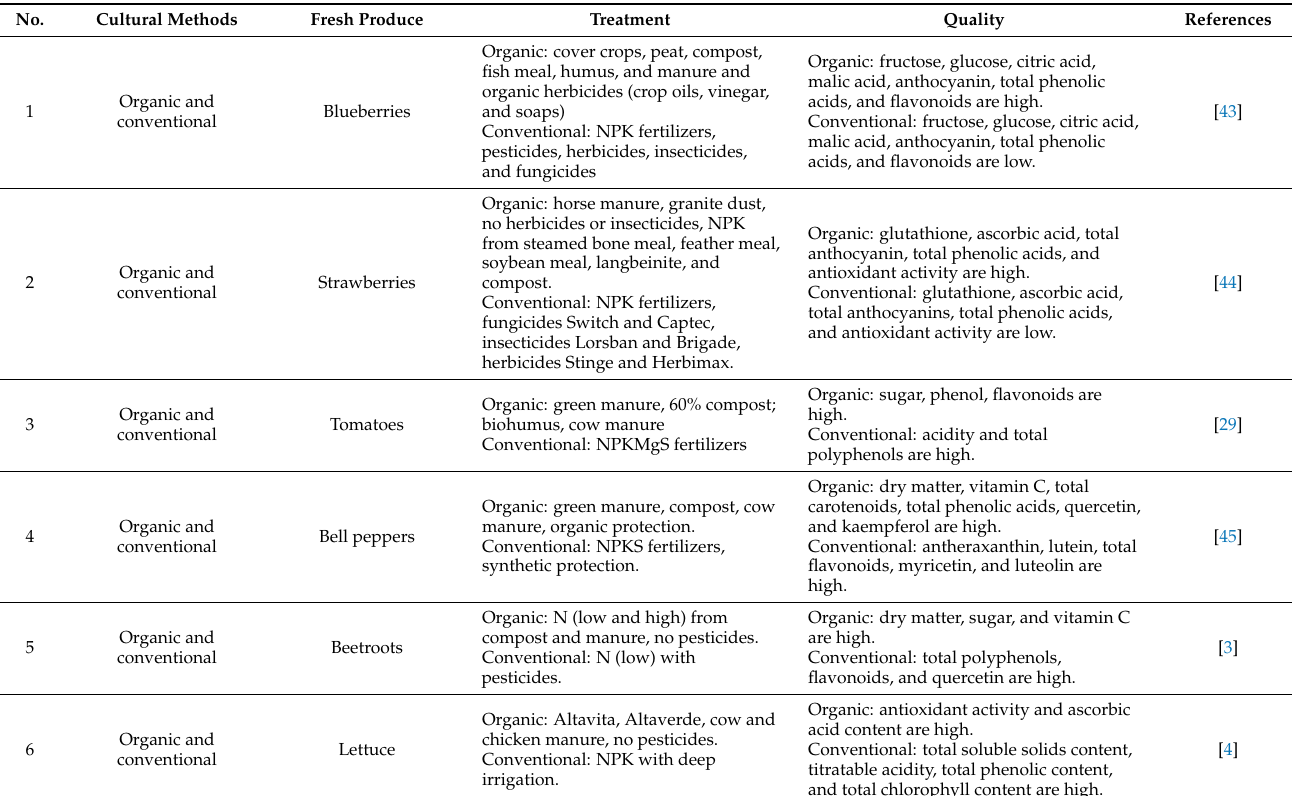
Table 5. The impact of organic and conventional methods on the quality of fresh produce.